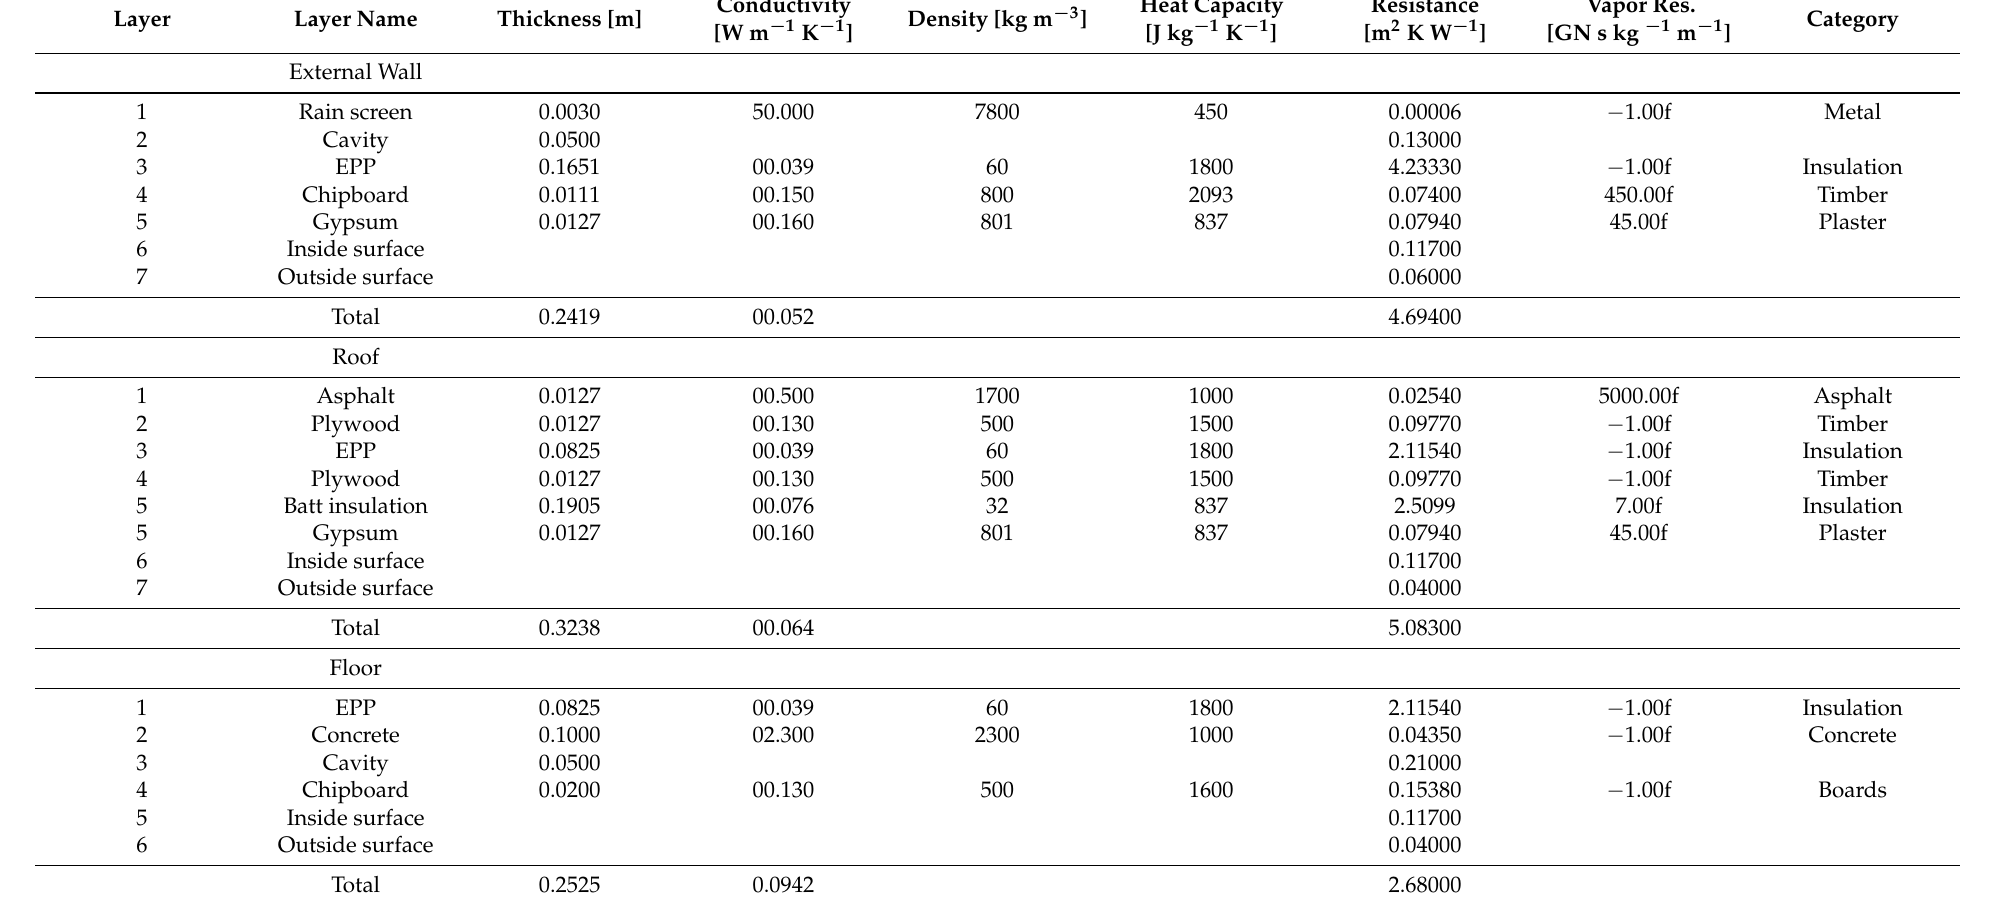
Table 3. Construction layer information for a high-performance building